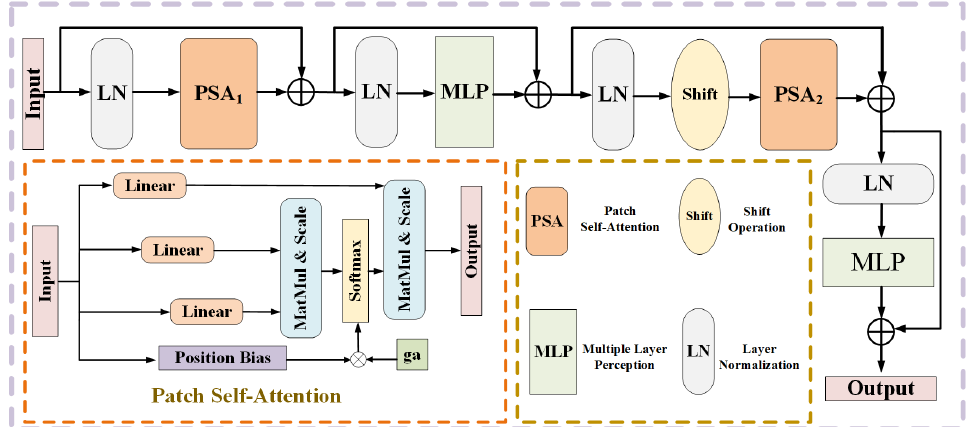
Figure 4. Details of the designed gated self-attention module. The calculation details of patch self-attention are shown in the orange dotted line